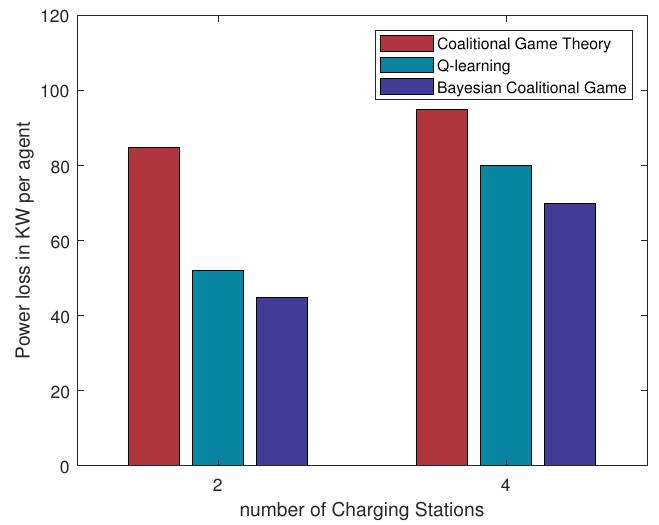
Figure 5. Average power loss versus the degree of